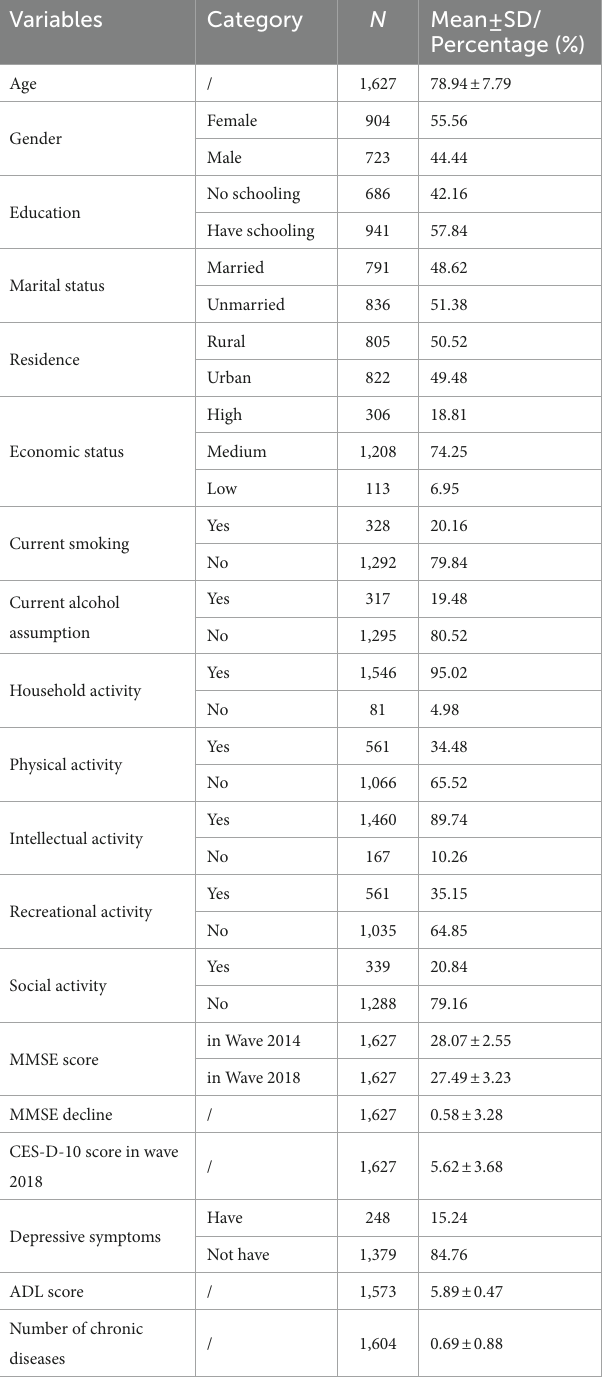
TABLE 1 Characteristics of the participants in baseline and